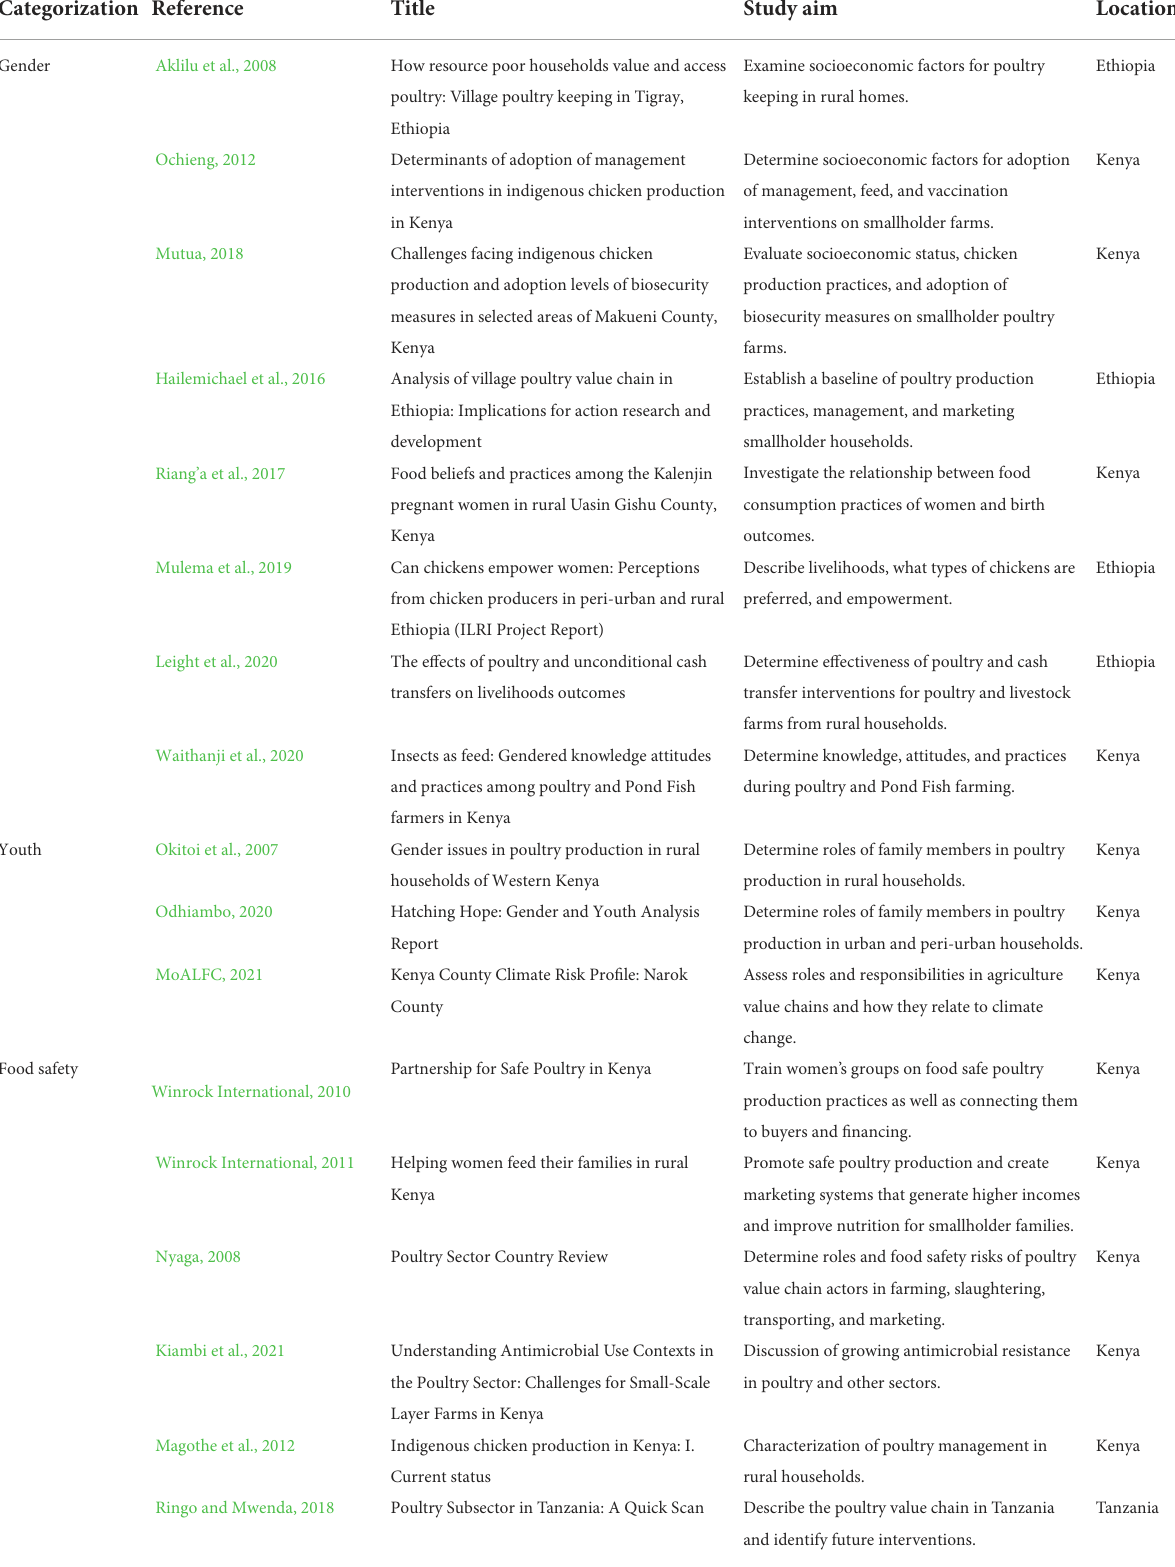
TABLE 2 Overview of articles on gender, youth, and food safety in the poultry value chain in East